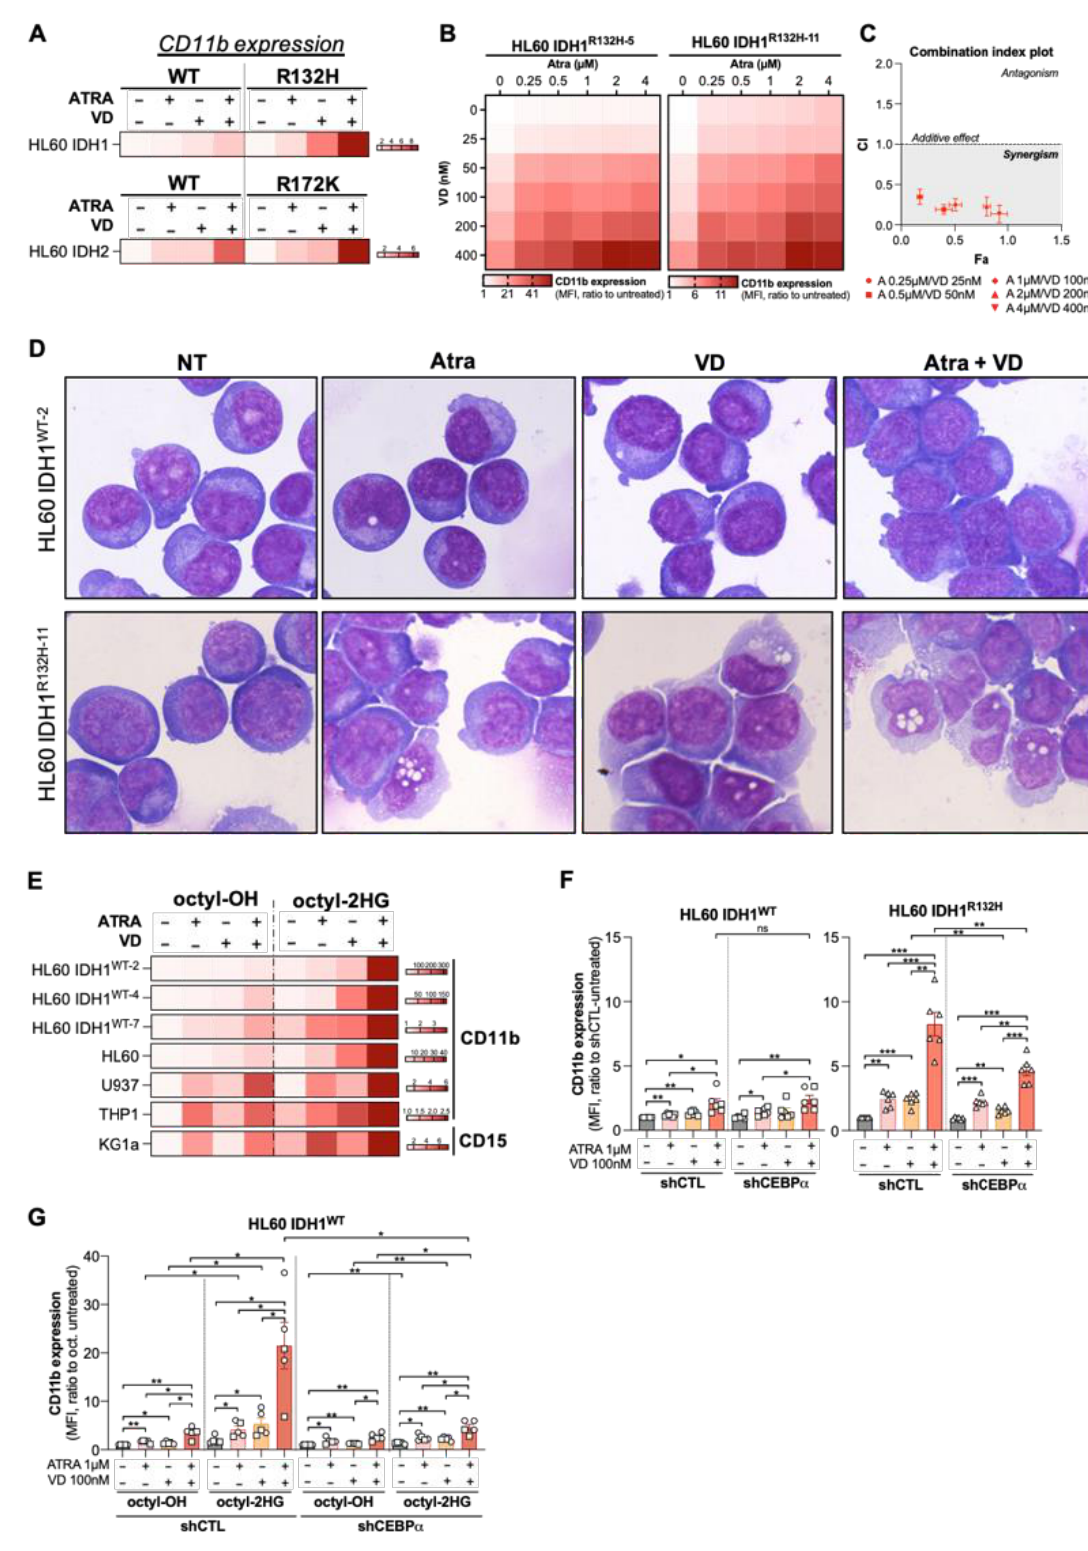
Figure 3. Combine treatment with VD and ATRA produces a synergistic induction of differentiation in a CEBP α -dependent manner. ( A ) HeatMap of CD11b expression (MFI, ratio to untreated) measured by flow cytometry in HL60 IDH1 WT versus HL60 IDH1 R132H and HL60 IDH2 WT versus HL60 IDH2 R172K treated for 3 days with ATRA (1 µM) and VD (100 nM)